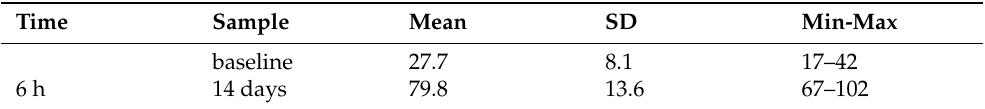
Table 1. Rabbit 25-OHD 3 (nmol/L) concentrations in juvenile domestic rabbits at baseline ( n = 6) and 14 days later ( n = 6) after 6 h of artificial UVB exposure per day. The samples collected at 14 days were significantly ( p = 0.002) higher than the